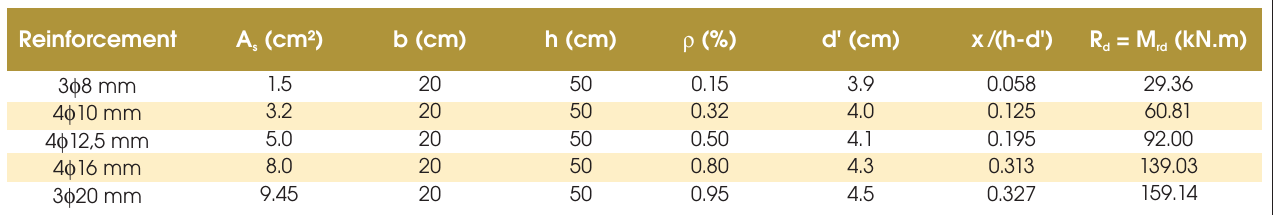
Table 3 – Rectangular reinforced concrete cross-sections analyzed and design resistance